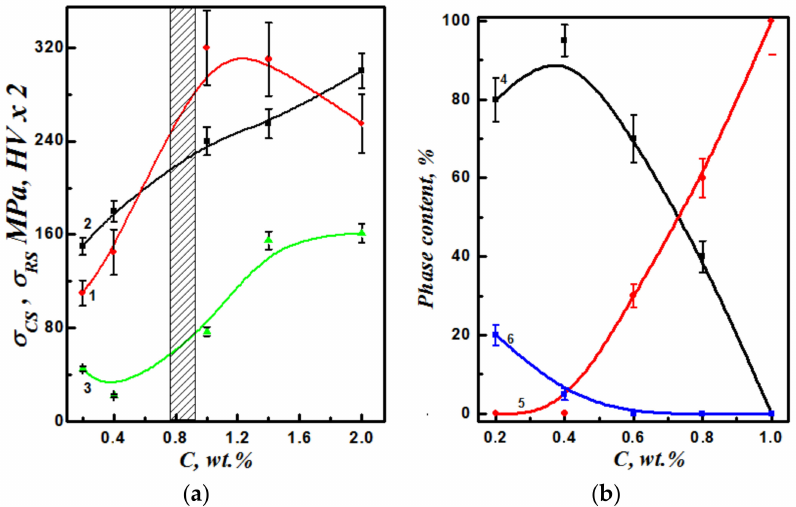
Figure 7. Mechanical properties: ( a ) Hardness HV (1), cohesive strength σ CS (2) and residual stresses σ RS (3) and ( b ) relative amounts of martensite (4), residual austenite (5), and ferrite (6) in coatings versus carbon content C in ASCs deposited by spraying of CW C(0.2 . . . 1.4)Cr14. Hatching highlights, the zone of optimal carbon content in the coating to provide the best combination of the analyzed